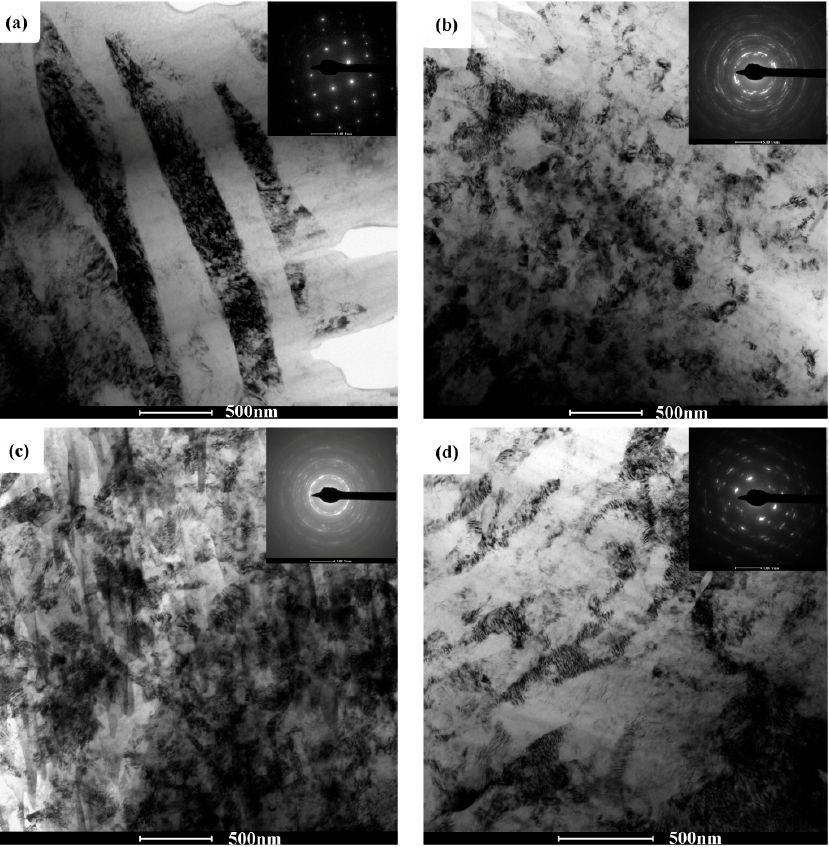
Figure 3. TEM images and corresponding selected area electron diffraction (SAED) patterns of various AZ61 magnesium alloys: ( a ) 1#, ( b ) 2#, ( c ) 3# and ( d ) 4#.